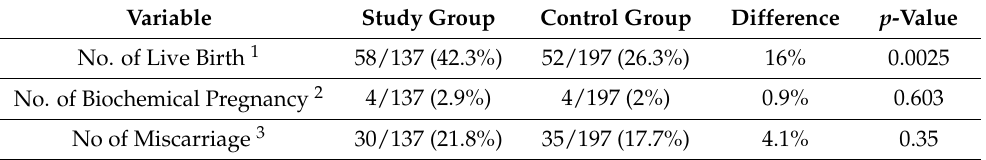
Table 3. Proportion comparisons for all